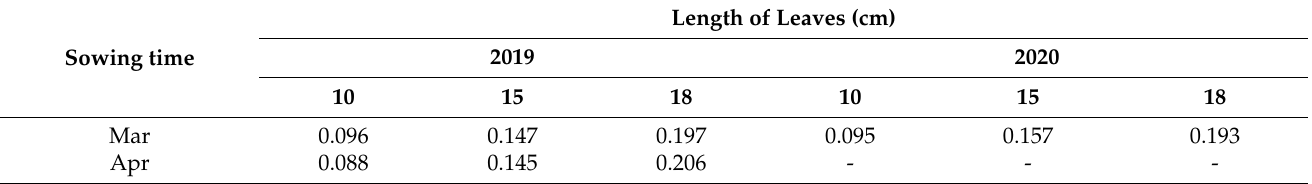
Table 2. Fresh weights (FWs, g) of 10, 15, and 18 cm barley sprouts grown in different months and